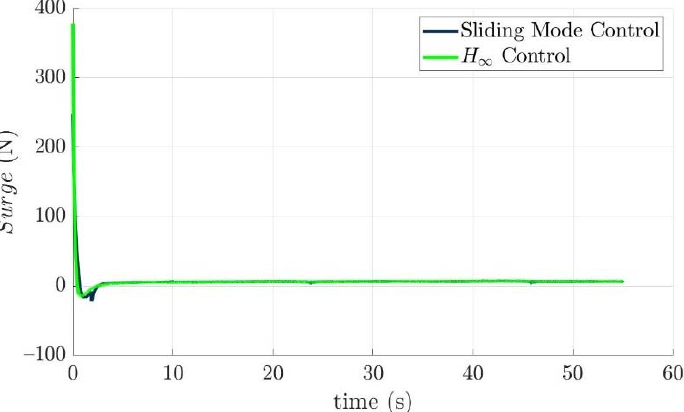
Figure 14. The velocities of the controlled torpedo-like underwater vehicle with respect to sliding mode control and the nonlinear H ∞ control law, respectively.